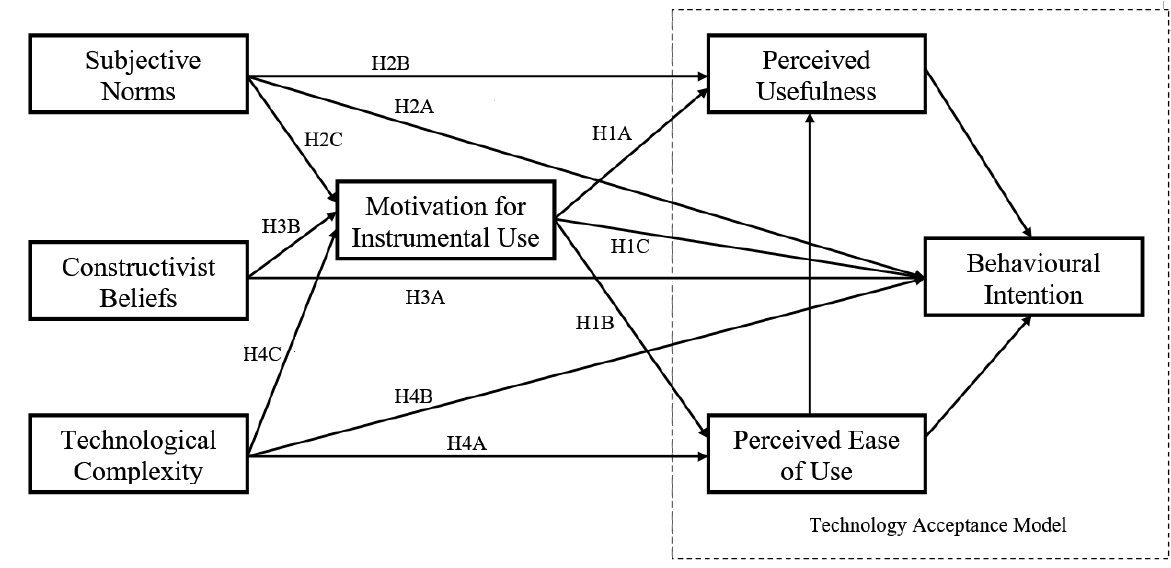
Figure 1 . E-Learning Systems Research